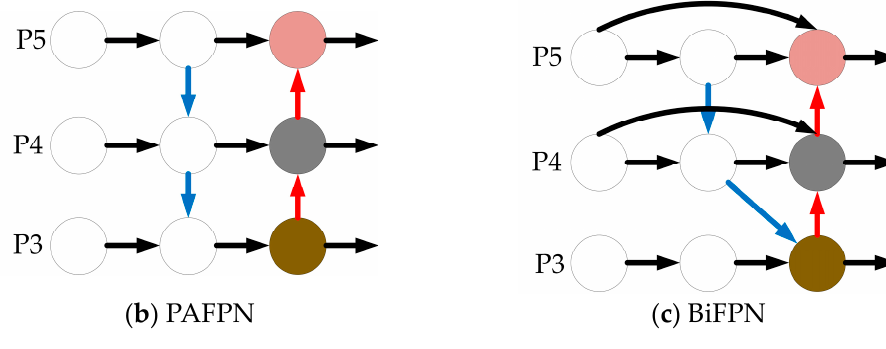
Figure 11. Comparison of di ff erent neck network structures.